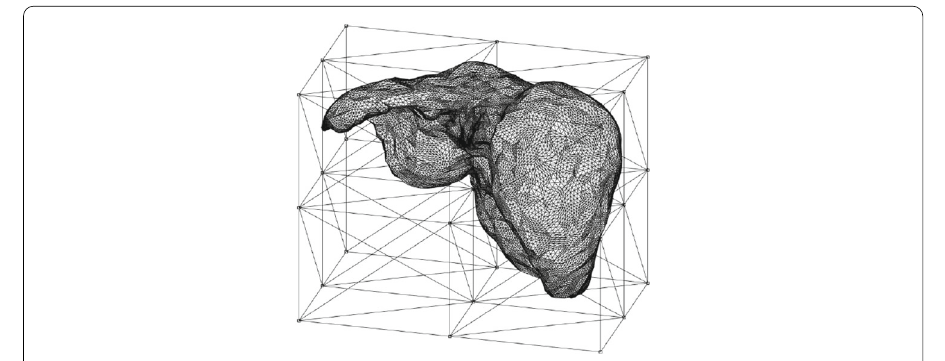
Fig. 3 Fine numerical and circumscribed mesh composed of respectively 201,627 and 81 space degrees of freedom (with tri-cubic C 1 interpolation). Note that the bottom left node has a non-zero sensitivity as a result of the cubic interpolation